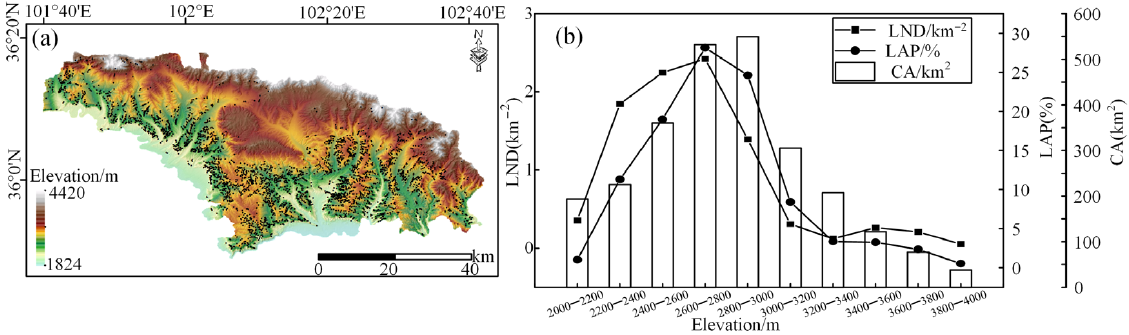
Figure 8. Relationship between elevation and landslide distribution. ( a ) Elevation distribution in the study area. ( b ) Statistics of landslide indicators in the elevation intervals.